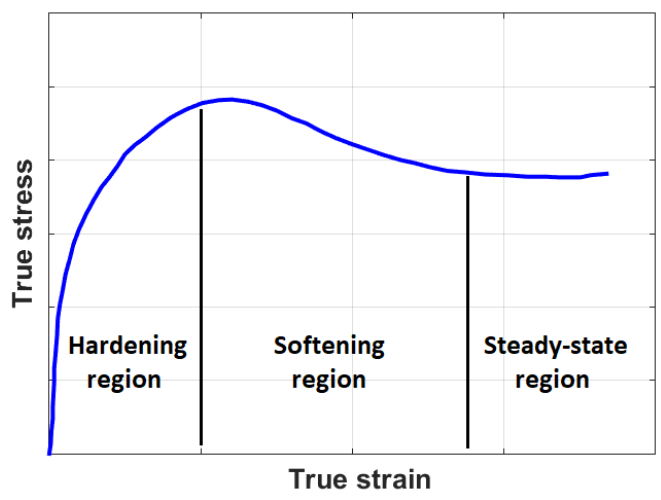
Figure 1. Common flow stress curve under hot deformation.